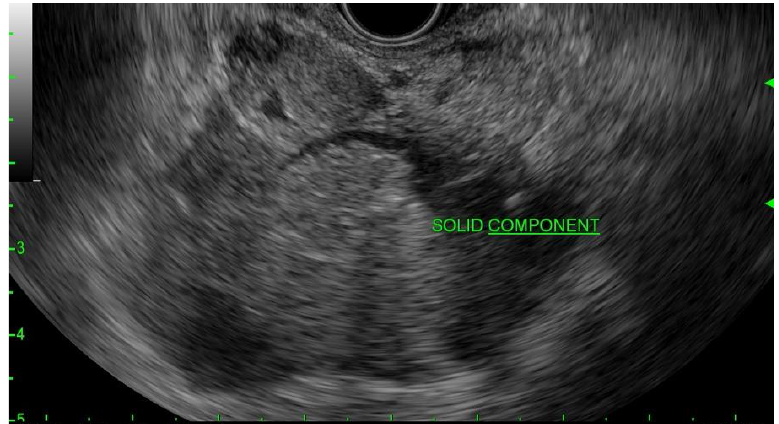
Figure 1. EUS image of the mural nodule (labeled solid component) in a mucinous